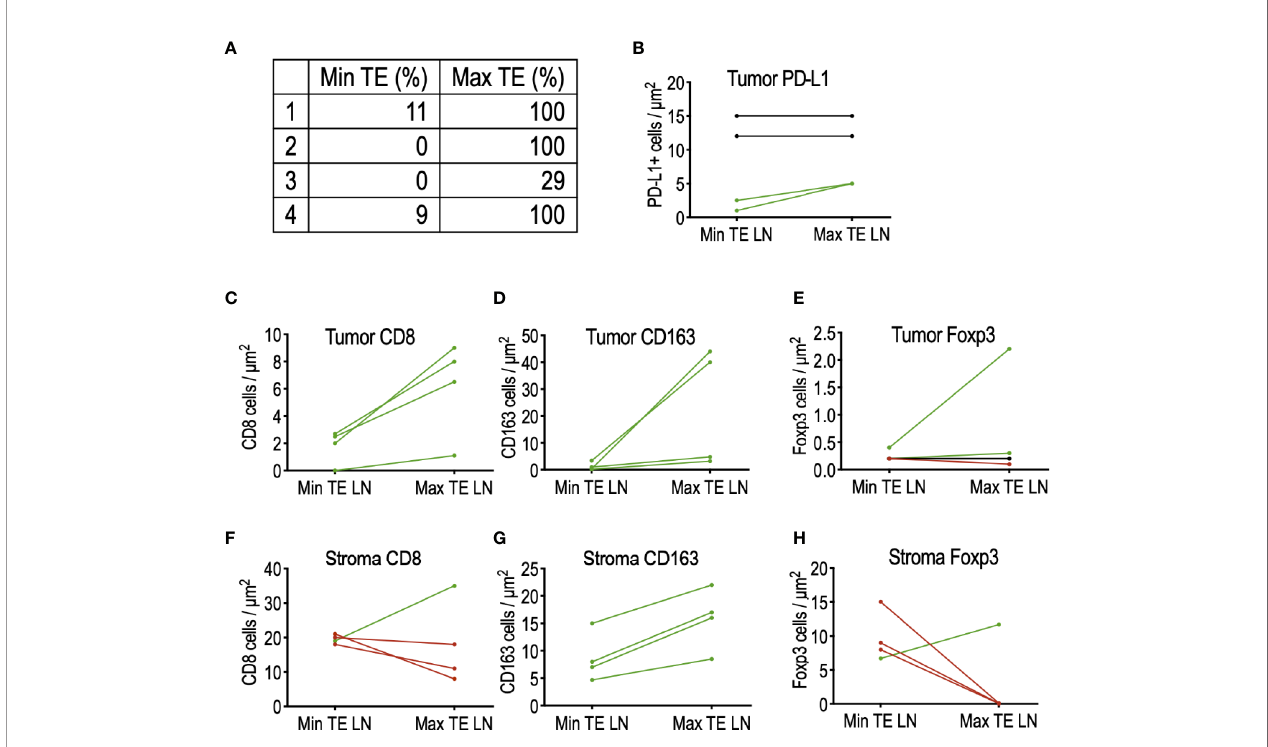
FIGURE 3 | Comparison of the tumor microenvironment in matched lymph nodes of four patients with highly discordant PTE. (A) List of matched lymph node PTE. (B) PD-L1 expression did not appear to in fl uence PTE between discordant LNs. (C) Histologic analysis of tumor-in fi ltrating immune cells demonstrated a trend toward increased CD8 T cells and (D) increased CD163 + macrophages in LN with maximal PTE; (E) no detectable trend was detected in tumor-in fi ltrating FoxP3 + Tregs. (F) No detectable relationship was found between stromal CD8 T cells and PTE, but (G) stromal CD163 + macrophages were increased in LN with maximal TE. (H) 75% of the max TE LN contained no stromal FoxP3 + Tregs, in sharp contrast to their matched min TE